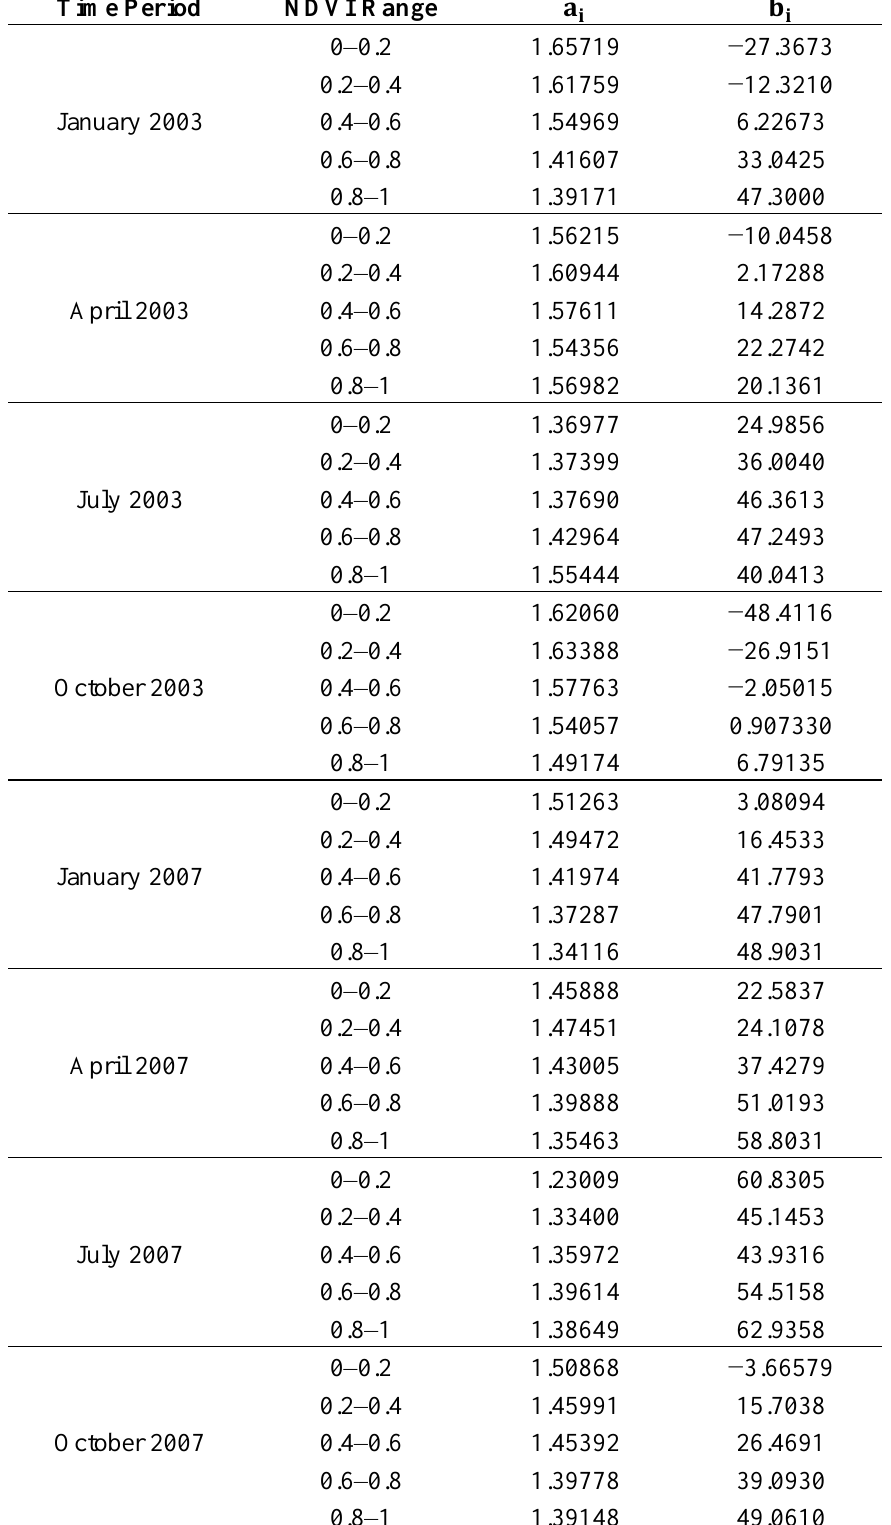
Table 2. Regression coefficients to convert 10-bit GOES-10 (year 2003) and GOES-12